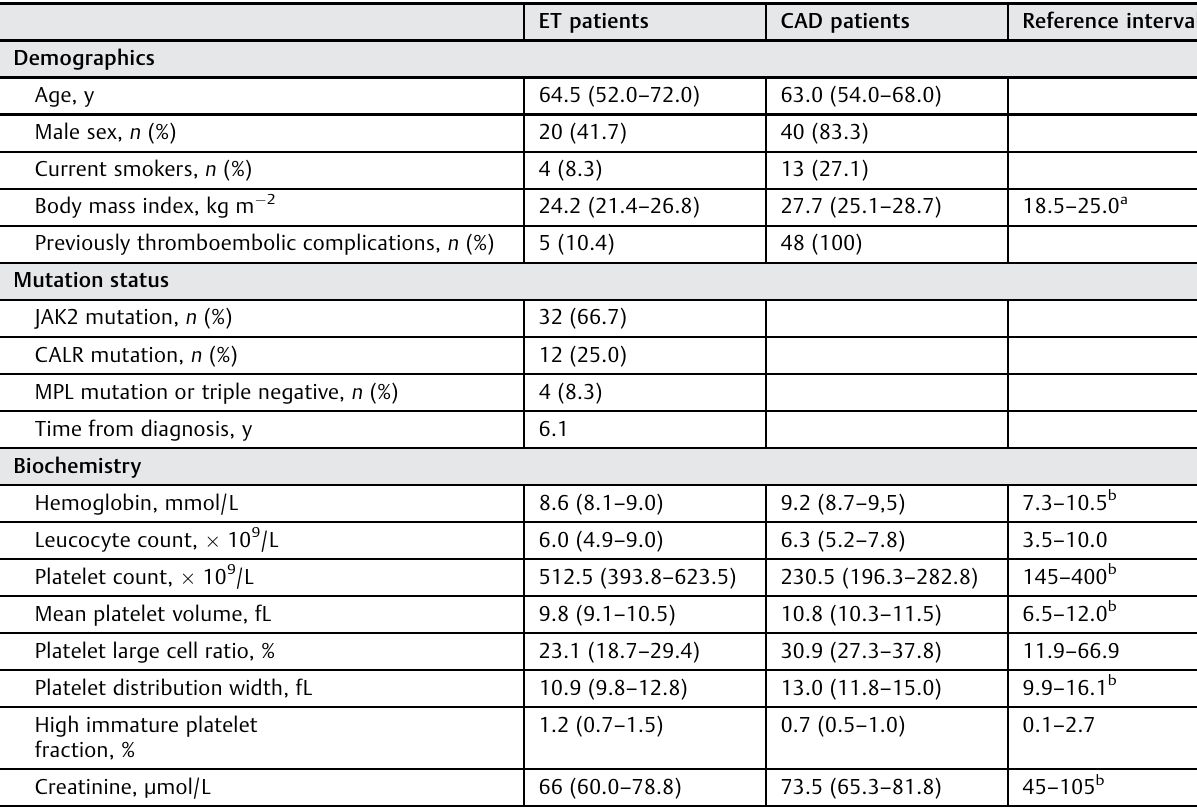
Table 1 Baseline characteristics of the study population with 48 patients with essential thrombocythemia (ET) and 48 patients with coronary artery disease